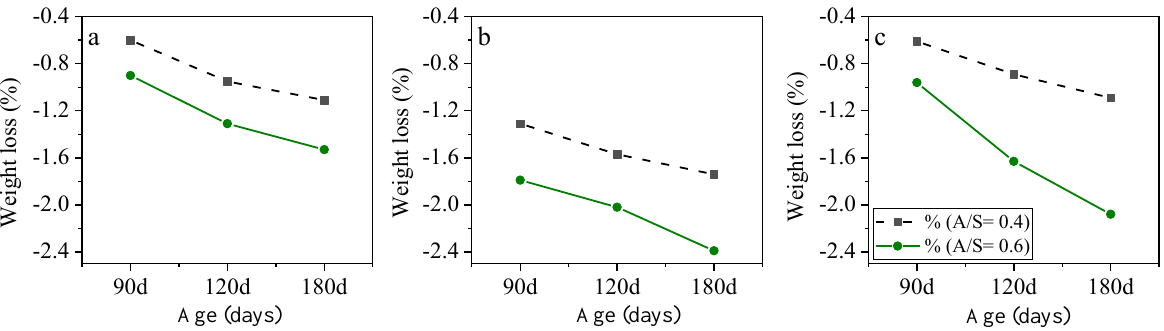
Figure 11. The effects alkaline solution to slag ratio on weight loss after acid exposure ( a ) molarity= 6 and NO/NS = 3, ( b ) molarity = 10 and NO/NS = 3, and ( c ) molarity = 10 and NO/NS = 1.